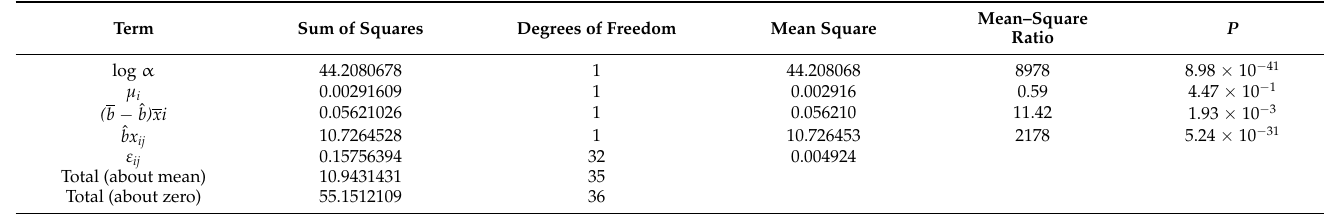
Table 3. One-way analysis of covariance outcomes to measure oxygen consumption in Japanese anchovies during the early development stages at 25 ◦